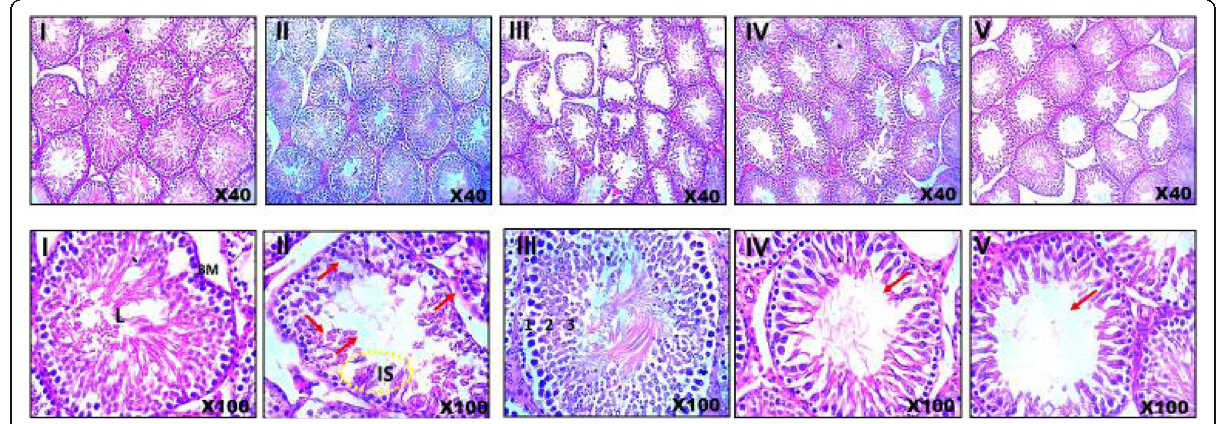
Fig. 2 Photomicrographs of the testicular Histomorphology of adult male Wistar rats across treated groups. H&E stain × 40 and × 100. The seminiferous epithelium and basement membrane (BM), The lumen (L) and interstitial space (IS) containing interstitial cells, spermatogonium (SG) (1 0 ,2 0 ,3 0 ) are well demonstrated across the testicular sections but not conspicuous at × 40